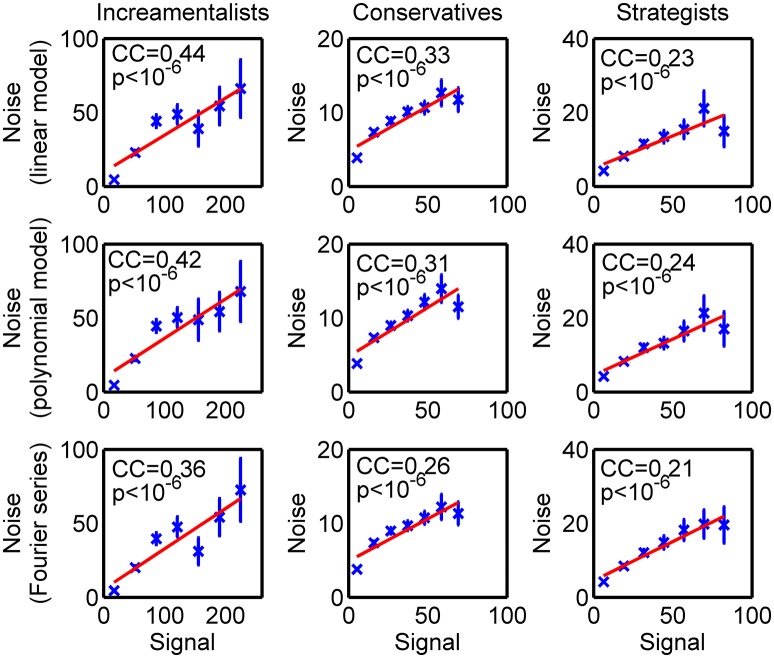
Signal-dependent noise. The strength of the signal at time t-1 was measured by the squared signal Xt-12, while the noise level of the residual process was given by the squared residual at time t (ût2) by different models (presented as the title of each subplot) of the BOLD time series. The strengths of the signals were binned into 7 bins. For each bin, the corresponding mean value (crosses) and the corresponding standard error (error bar) of the noise levels in each bin were established. The lines are the linear fits of the mean values of the noise levels to the centers of bins of the strengths of the signals. The correlation coefficients (CC) between the noise level and the strength of the signal as well as the corresponding p-values (p) are also reported.